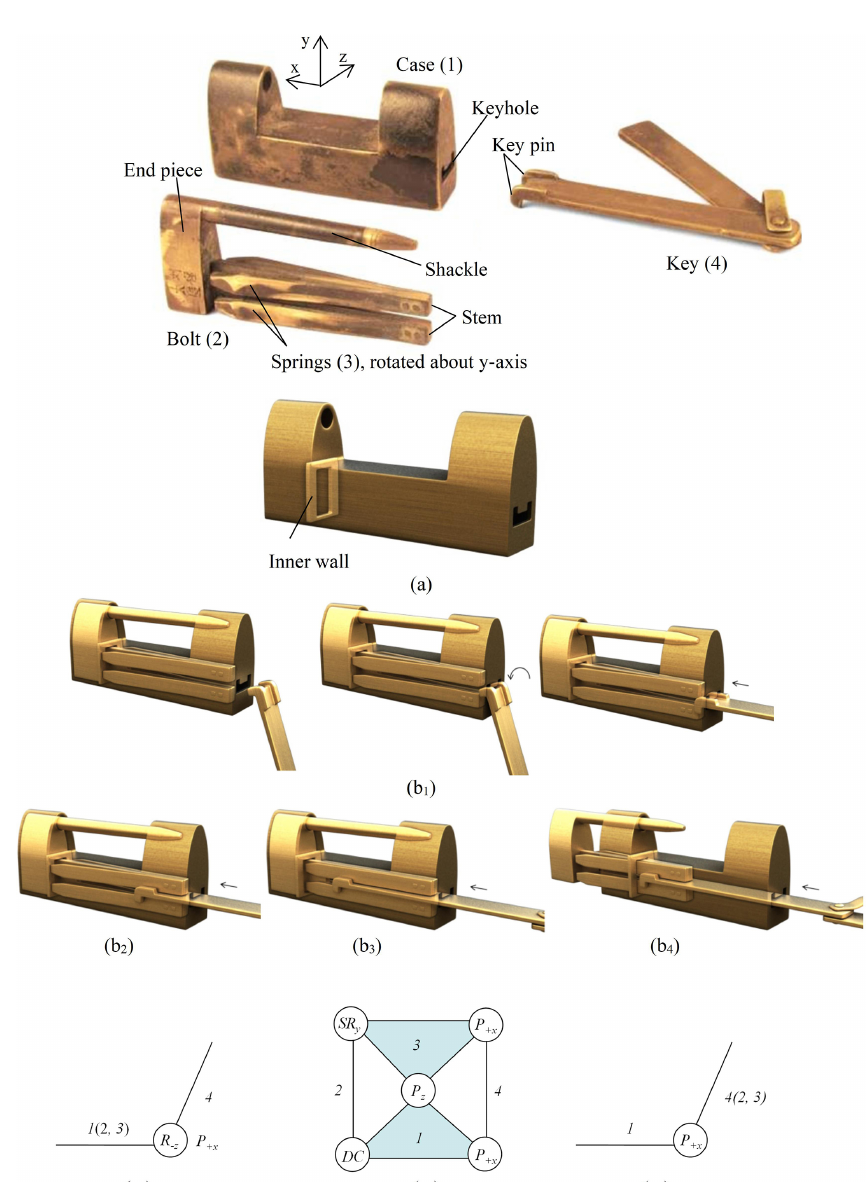
Figure 2. Ordinary barbed-spring padlock (National Science and Technology Museum collection).